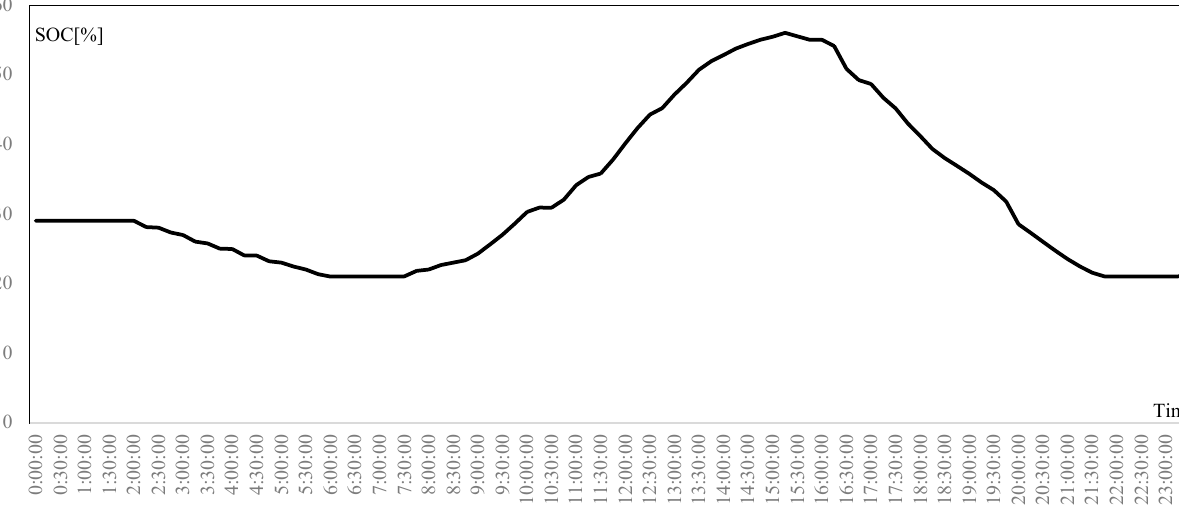
Figure 15. ESS state of charge.